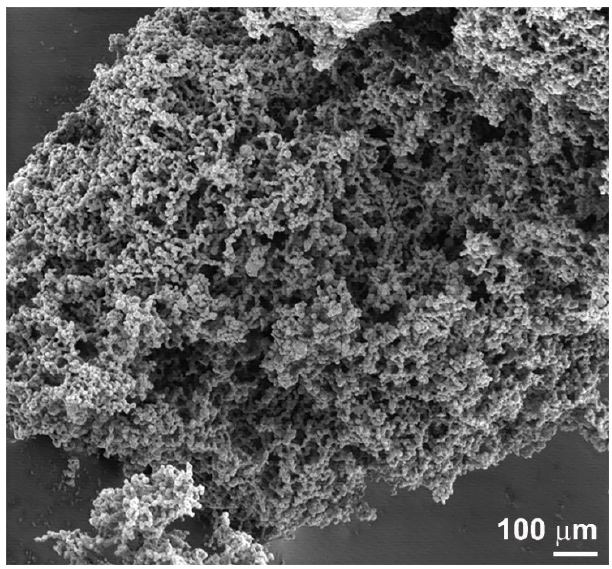
Figure 11. Secondary electron beam micrograph taken at 1 kV for MgH 2 /5 wt% (2.5 ZrNi 5 /2.5 Nb 2 O 5 ) powders after completion 228 cycles conducted at 200 °C.